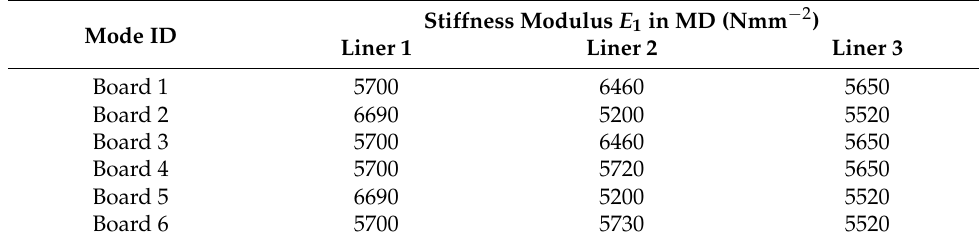
Table 1. Stiffness moduli for individual flat layers of corrugated board.